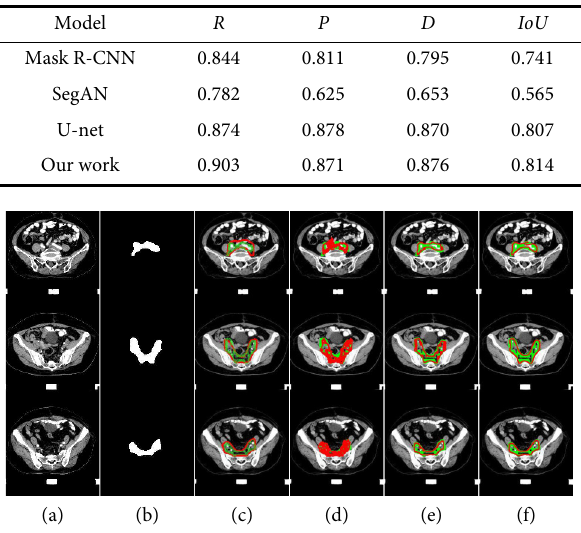
Table 1 Evaluation results of models.